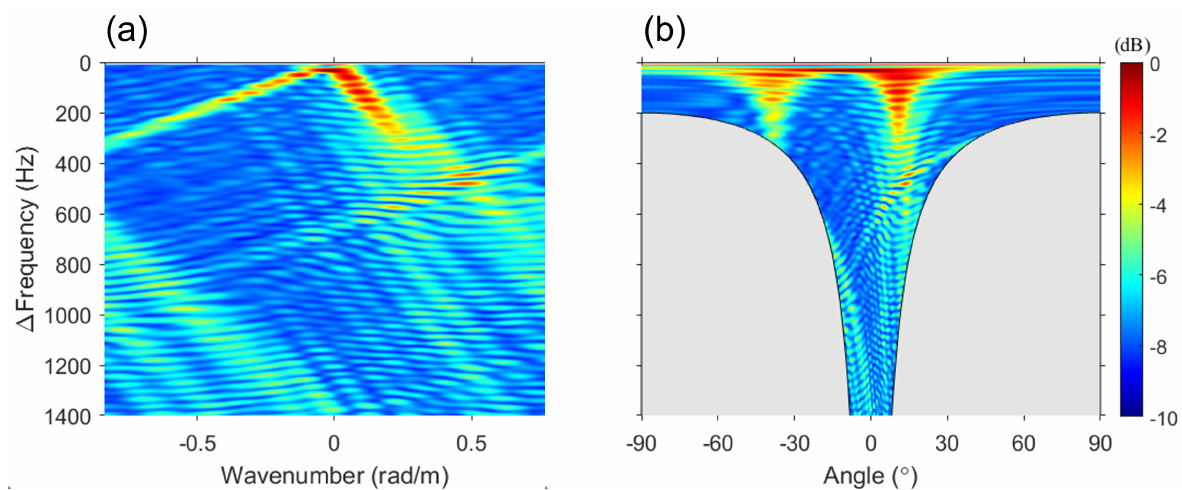
Figure 8. ∆ f – k analysis of experimental data. ( a ) Difference frequency–wavenumber domain and ( b ) difference frequency–angle domain. As expected from Figures 3 and 7, the ∆ f – k analysis of cracking sounds is similar to that of simulation data.